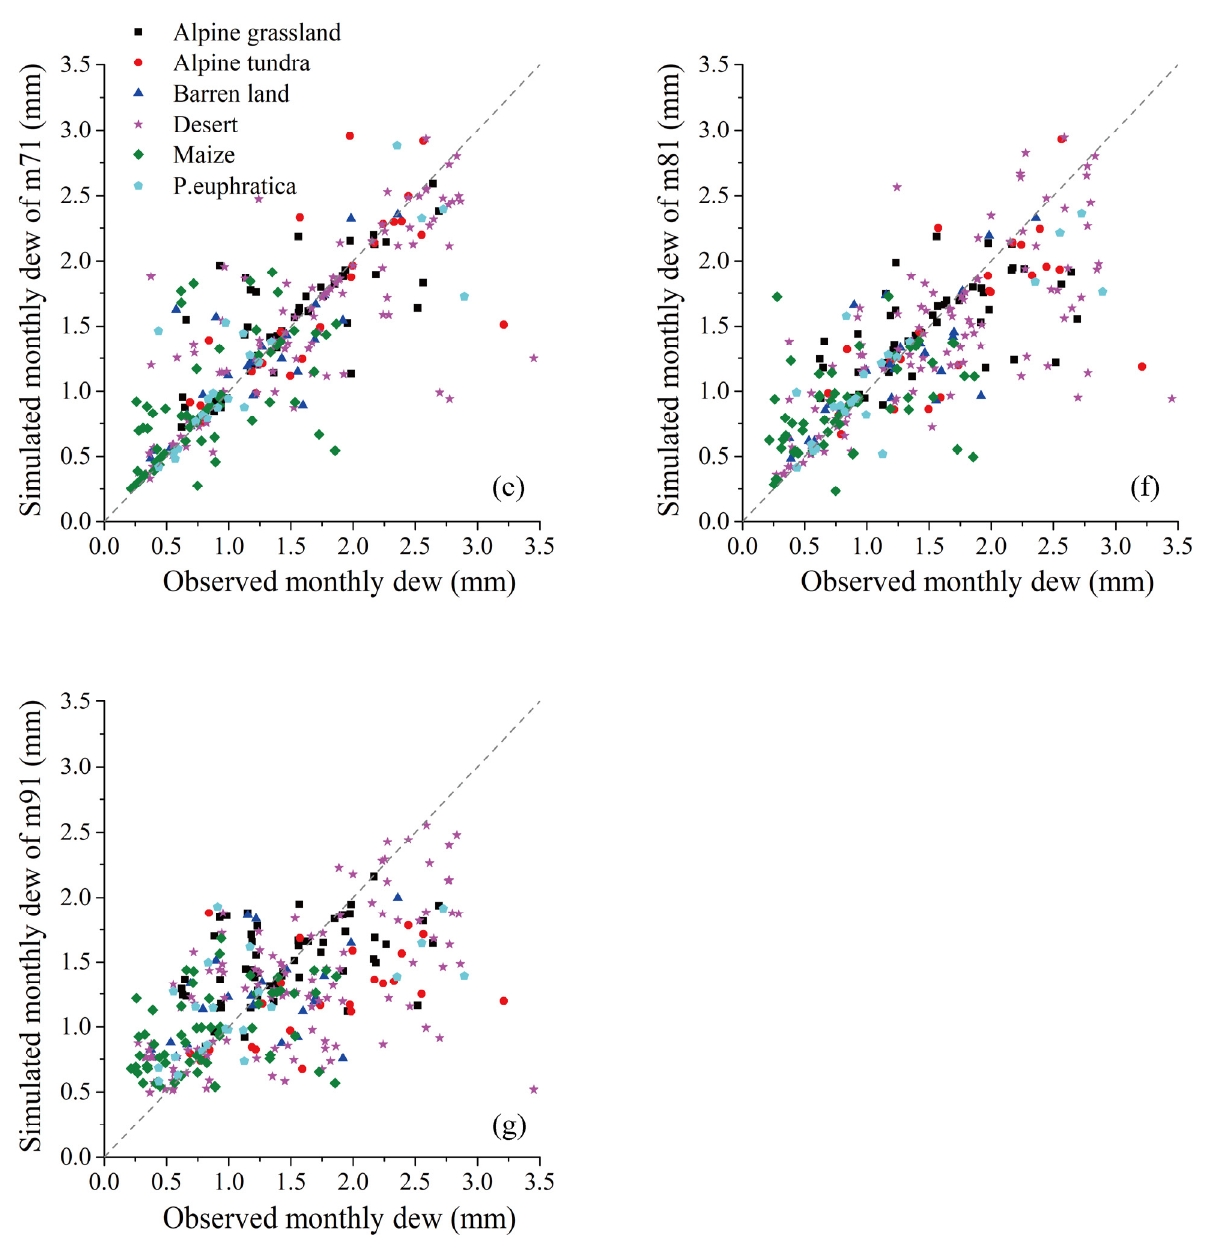
Figure 5. The scatter plots of the simulation results under different numbers of variables: ( a – g ) 3–9 variables, respectively.